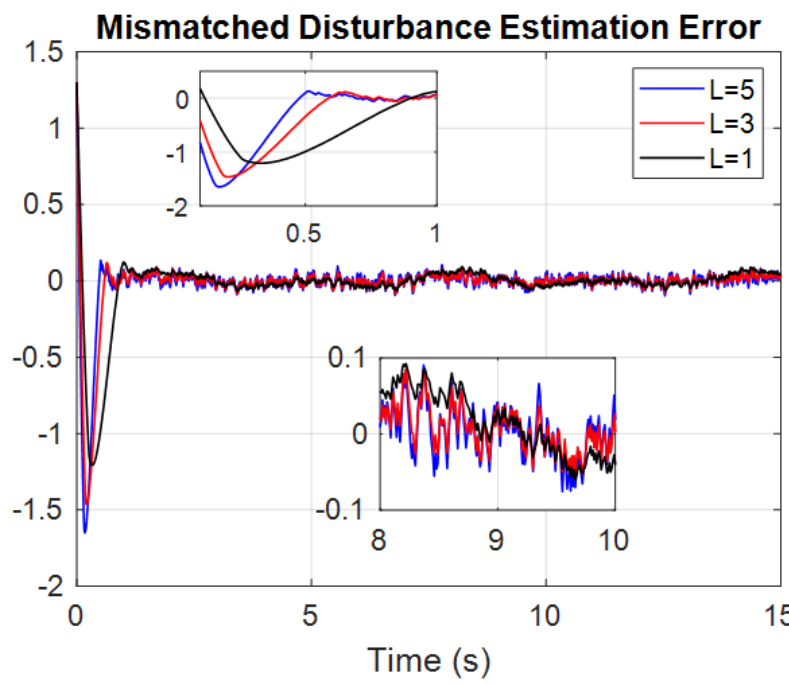
Figure 6. Influence of design parameters on observer performance.